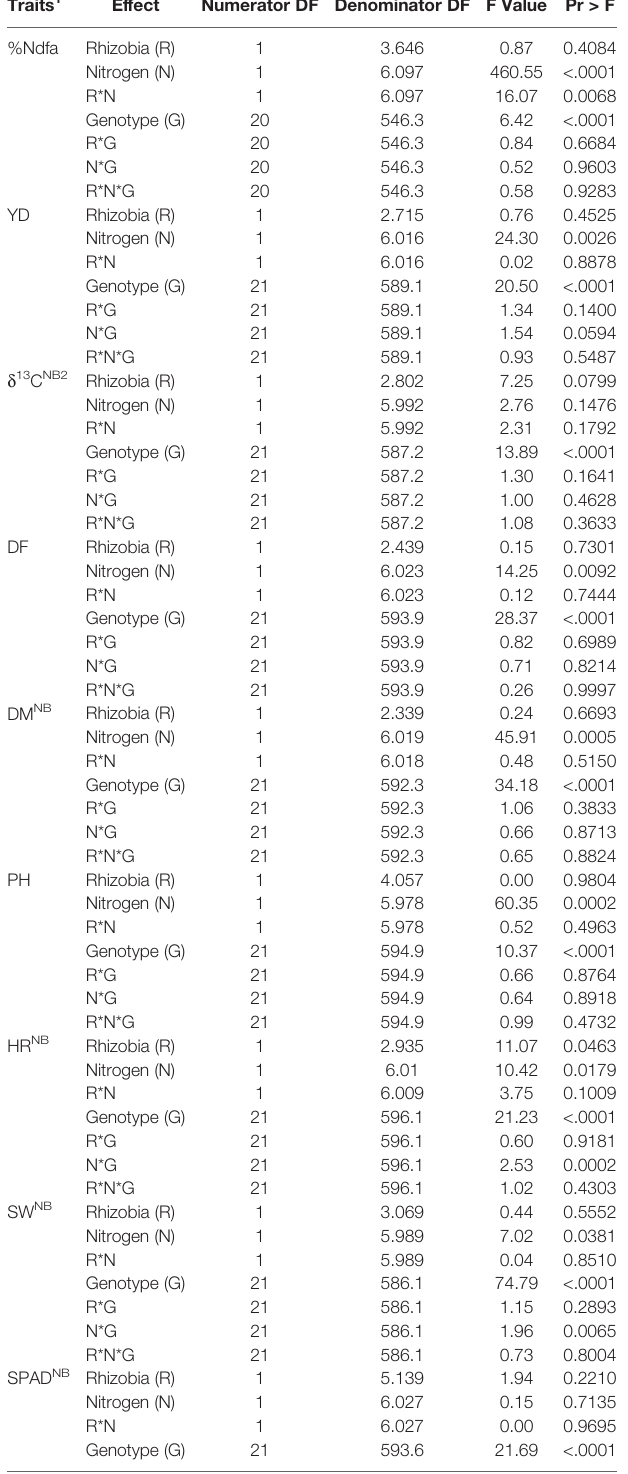
TABLE 5 | Type III tests of fi xed effects from restricted likelihood analysis of split- split plot experiments with 22 common bean genotypes conducted at the Elora research station (ON, Canada) on created K-P land in 2017 and 2018